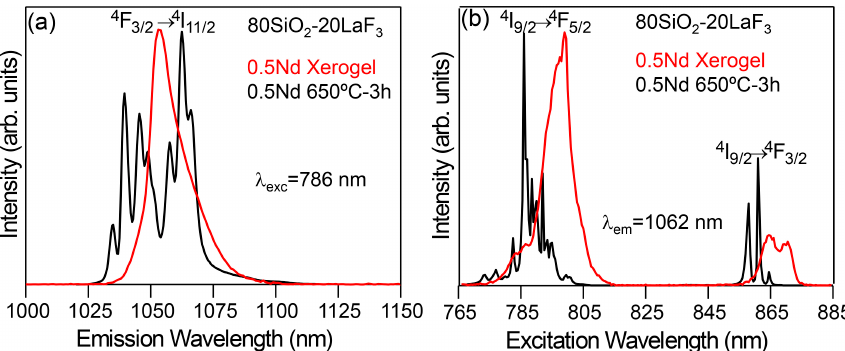
Figure 13. PL ( a ) emission and ( b ) excitation spectra of 80SiO 2 -20LaF 3 bulk xerogel and GC treated at 650 °C for 3 h. All spectra were recorded at 9 K.